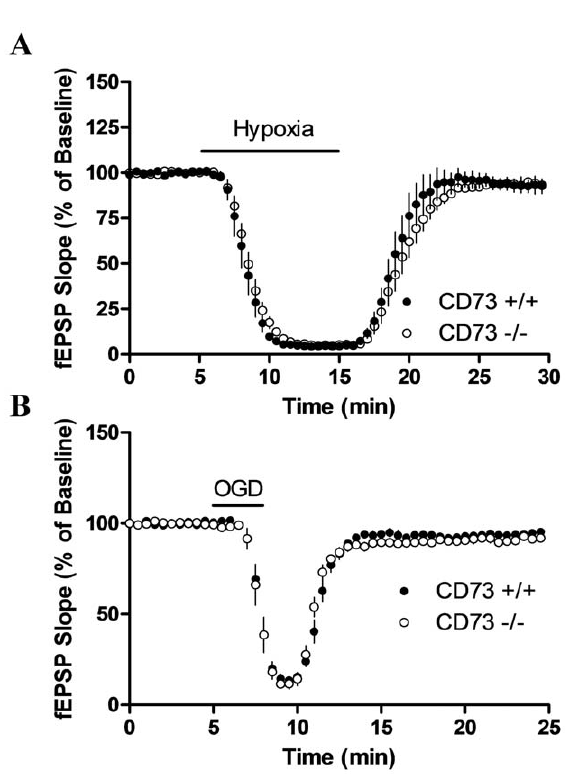
Figure 6. Effect of hypoxia or oxygen-glucose deprivation (OGD) on fEPSP recordings. (a) Slices were superfused with hypoxic aCSF for 10 min as indicated by the horizontal bar. n =7 CD73 + / + or 9 CD73 2 / 2 mice. (b) Slices were superfused with hypoxic glucose-free aCSF for 3 min as indicated by the horizontal bar. n =5 CD73 + / + or 4 CD73 2 / 2 mice. There were no significant differences between genotypes.